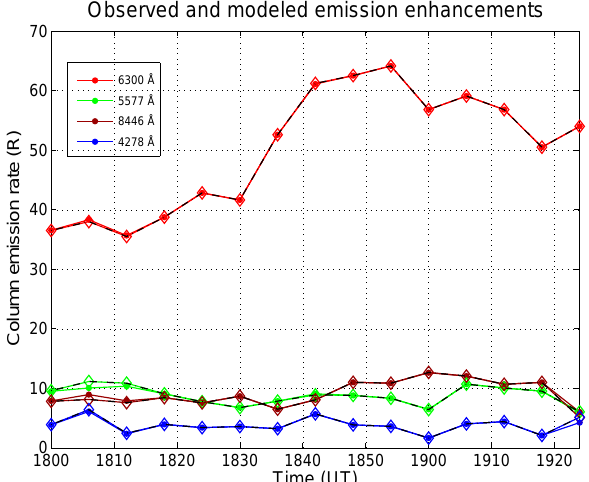
Fig. 5. Modeled electron enhanced emission rates, marked with diamonds and dot-dashed lines, agree well with the observed en- hancements, marked with dots. The fit between observed and mod- eled emissions is almost perfect. For the 6300 and 8446 lines the differences are noticeable only for the second pulse. For 5577 it is possible to see deviations for the second and third pulse. For 4278, only the last pulse has an error large enough to be